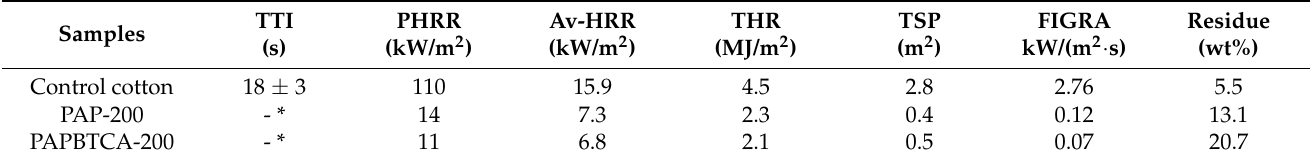
Table 3. CCT data of the control, PAP-200, and PAPBTCA-200. Samples